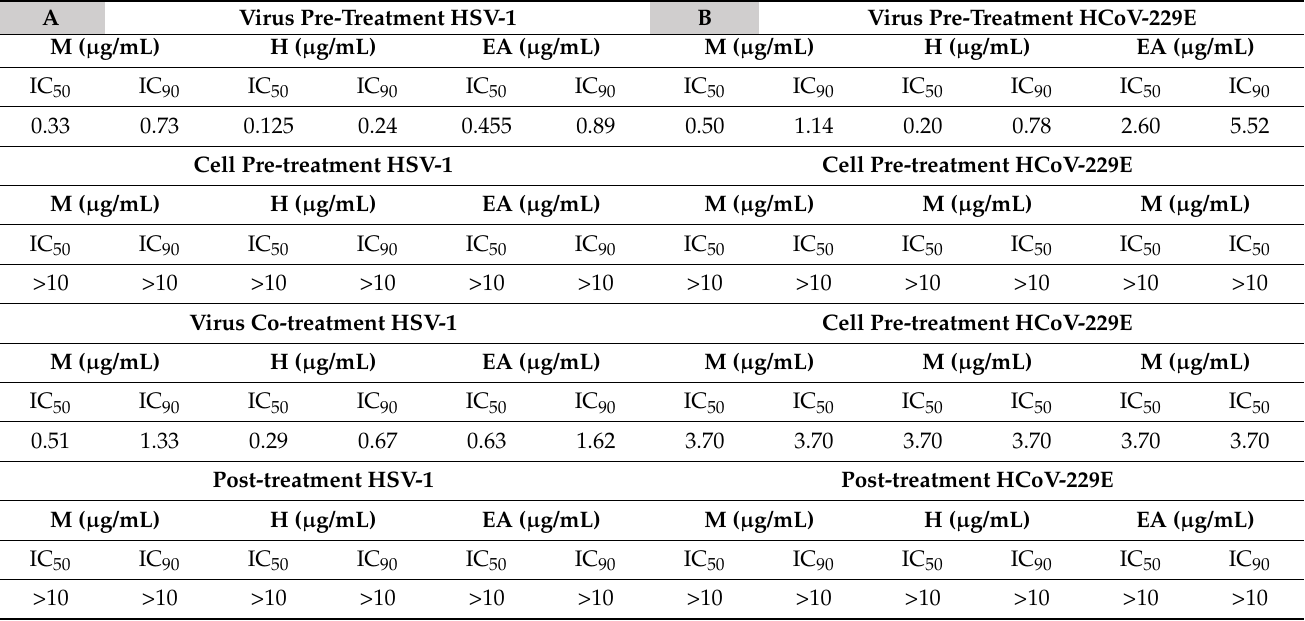
Table 3. IC 50 and IC 90 of M, H, and EA against HSV-1 (A) and HCoV-229E (B) in virus pre-treatment, cell pre-treatment, co-treatment, and post-treatment